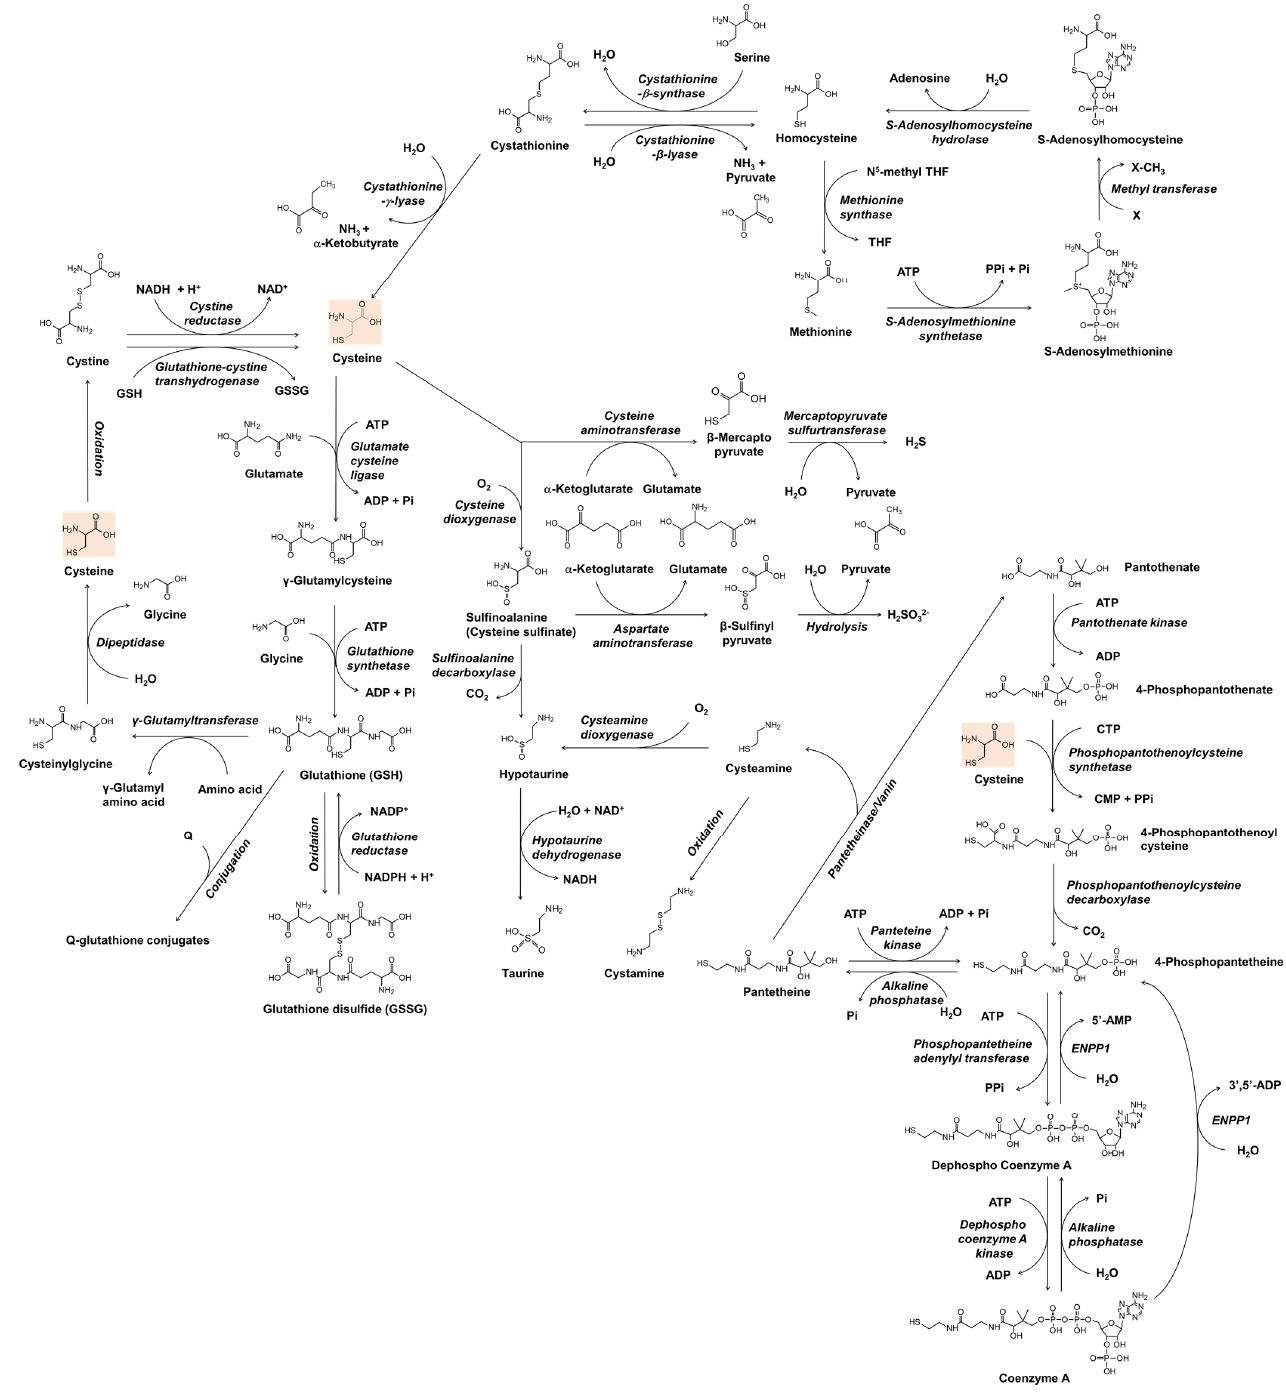
Figure 1. The metabolism of cysteine and related thiol compounds in mammals. ADP, adenosine diphosphate; AMP, adenosine monophosphate; ATP, adenosine triphosphate; CDP, cytidine diphosphate; CTP, cytidine triphosphate; ENPP1, ectonucleotide pyrophosphatase/phosphodiesterase 1; GSH, glutathione; GSSG, glutathione disulfide; NAD + , nicotinamide adenine dinucleotide; NADH, nicotinamide adenine dinucleotide hydrogen; NADP + , nicotinamide adenine dinucleotide phosphate; NADPH, nicotinamide adenine dinucleotide phosphate hydrogen; Pi, inorganic phosphate; PPi, inorganic pyrophosphate; Q, substrates or reactants for glutathionylation; THF, tetrahydrofolate; X, substrates for methylation.